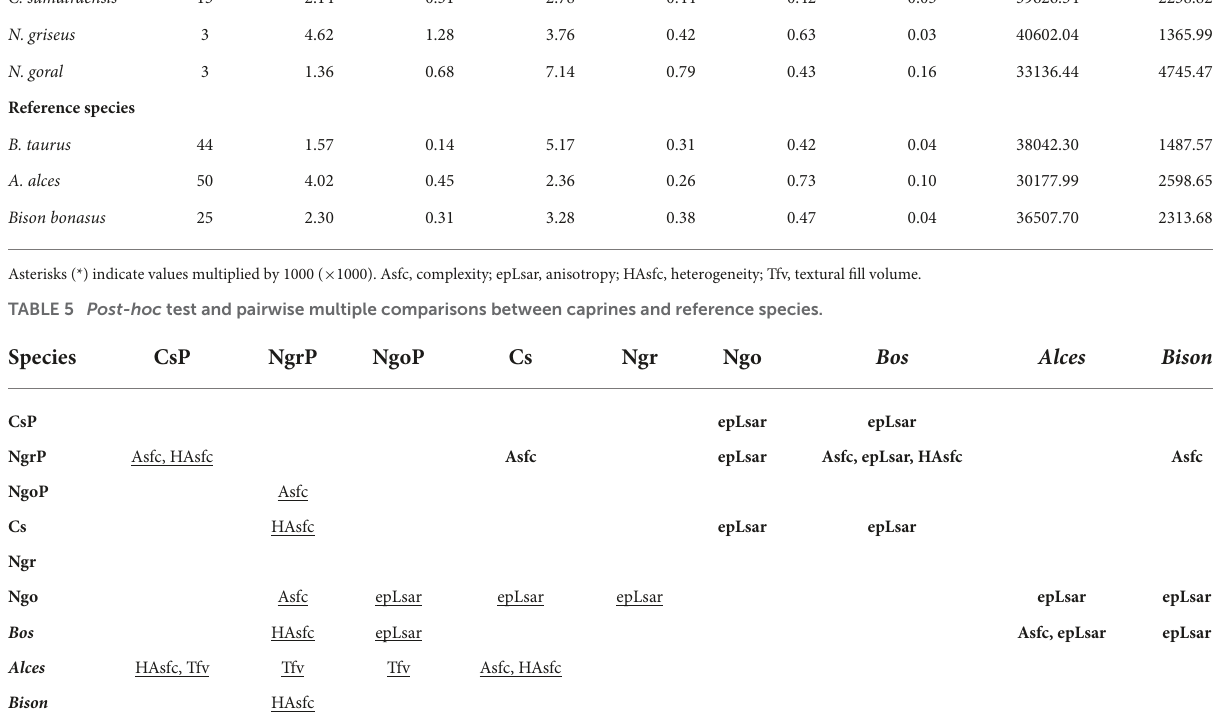
epLsar epLsar Asfc epLsar